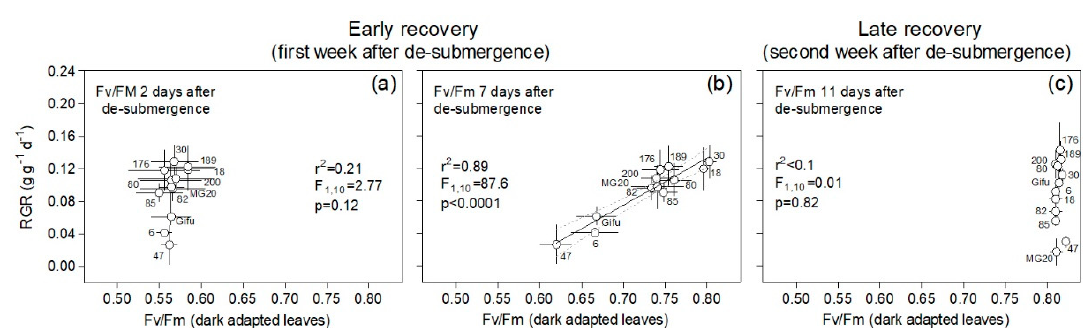
Figure 6. Plant relative growth rate (RGR) during ‘early’ and ‘late’ recovery vs. chlorophyll fluorescence on the top-most fully expanded dark-adapted leaves (Fv / Fm) at days 2, 7, and 11 after de-submergence for plants of 12 genotypes of Lotus japonicus (10 recombinant inbred lines and their parents Gifu and MG20). The first week after de-submergence was used to explore the relationship between these variables in an ‘early recovery’ phase ( a , b ) and the second week in a ‘late recovery’ phase ( c ). Values are means ± standard errors (n = 6–8 for RGR and n = 5 for Fv / Fm). The Fv / Fm values corresponding to the control treatment ranged between 0.803 and 0.816 (all data for each genotype and measurement dates are available in Table S4).